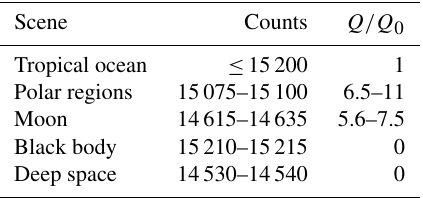
Table 2. The range of relative values of the non-linearity term Q in the measurement equation for different scenes. The counts are from channel 20 in different orbits with Moon intrusions from the year 2008. Q 0 is the non-linearity correction for observations over tropical ocean.